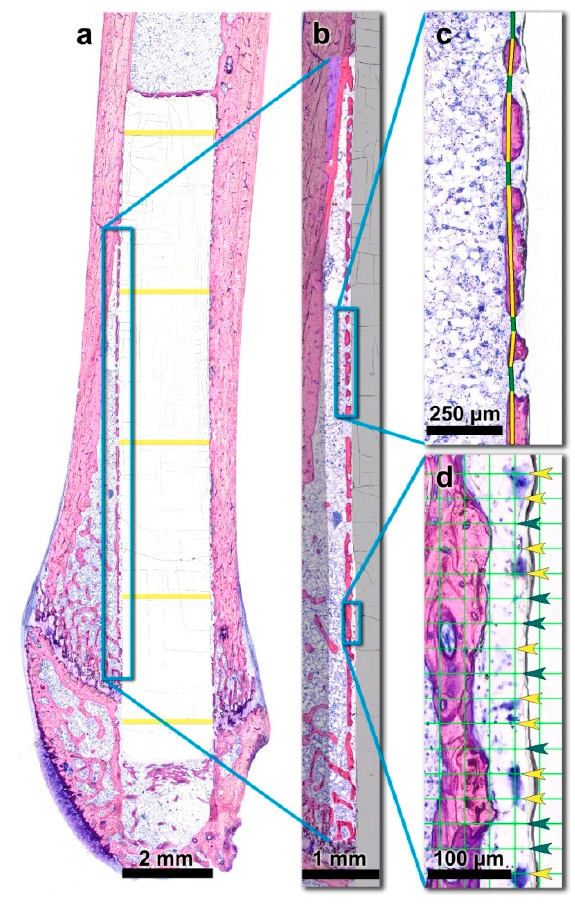
Figure 2. Histomorphometric measurements were based on the histological thin-ground sections of the right femora. ( a ) The region of interest (ROI) is indicated by the blue rectangle. The diameter of the PLGA implant was measured at five predefined, evenly distributed sites over the length of the rods (yellow lines) and averaged per individual. ( b ) New bone volume fraction (nBV/TV) was assessed within the indicated ROI which was segmented into new bone tissue (red), old bone tissue (blue) and soft tissue/medullary space. ( c ) Peri-implant bone capsule (piBC) was defined as the percentage of the rod's surface that is surrounded by newly formed bone. New bone was marked with a yellow line, interspersing soft tissue with a green line. ( d ) The presence of peri-implant multinucleated giant cells (piMGCs) was assessed with a point counting grid (grid line distance: 30 µm) as the percentage of the rod surface that is lined by MGCs (Yellow arrowheads: grid nodes with an underlying MGC, green arrowheads: intermediate grid nodes).